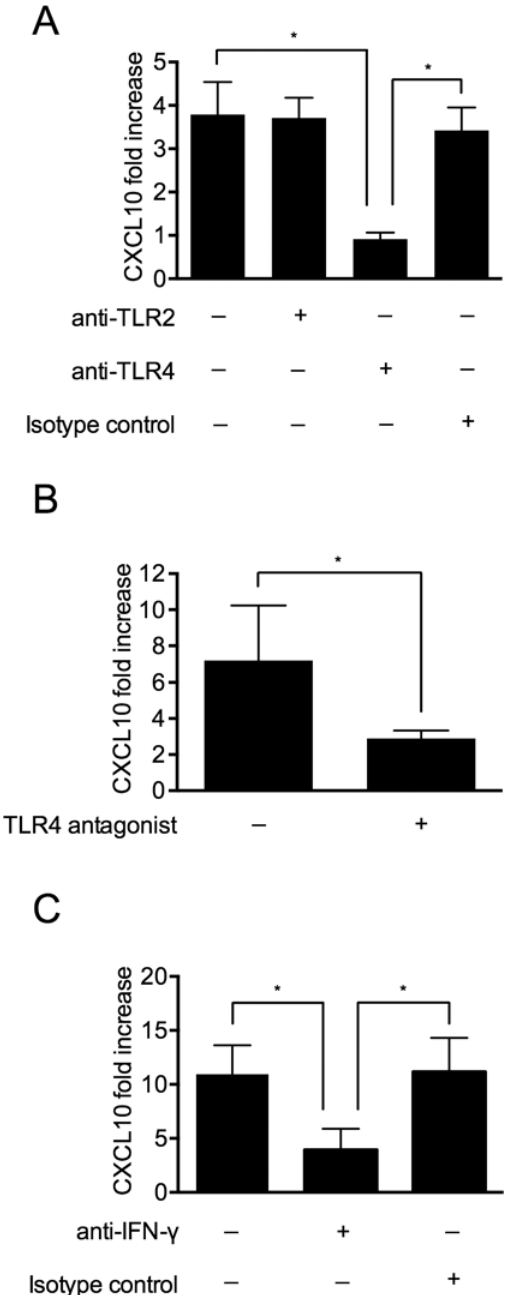
Fig 3. Histone-induced CXCL10 production is dependent on TLR4 and IFN- γ . (A) CTHs (60 μ g/ml) were added to heparinized blood in presence of antibodies against human TLR2 (25 μ g/ml), human TLR4 (25 μ g/ ml) or isotype control (25 μ g/ml). After a 12-hour incubation at 37°C, the release of CXCL10 was measured. Blood stimulated with CTHs in the absence of an antibody served as control. (B) CTHs (60 μ g/ml) were mixed with heparinized blood in the presence or absence of the TLR4 antagonist CLI-095 (1.25 μ g/ml). After a 12-hour incubation at 37°C, the release of CXCL10 was measured. Blood stimulated with CTHs in the absence of antagonist served as control. (C) CTHs (60 μ g/ml) were incubated with heparinized blood in presence of antibodies against human IFN- γ (25 μ g/ml) or an isotype control (25 μ g/ml). After a 12-hour incubation at 37°C, the release of CXCL10 was measured. Blood stimulated with CTHs in the absence of an antibody served as control.